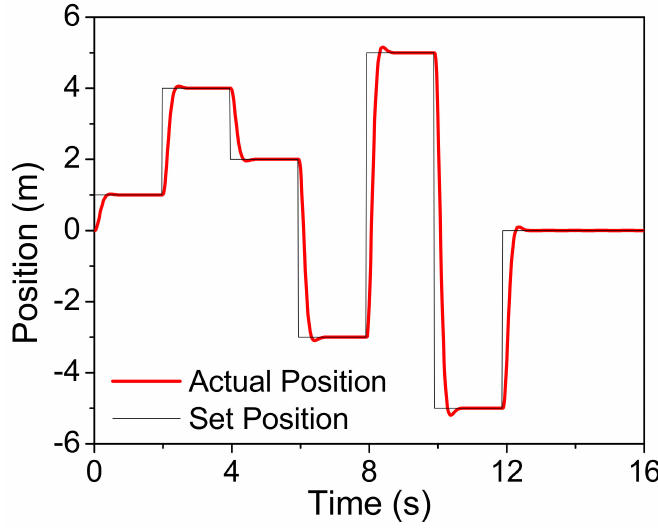
Figure 8. Position tracking of the performance of the system with PID parameters recommended by the neural